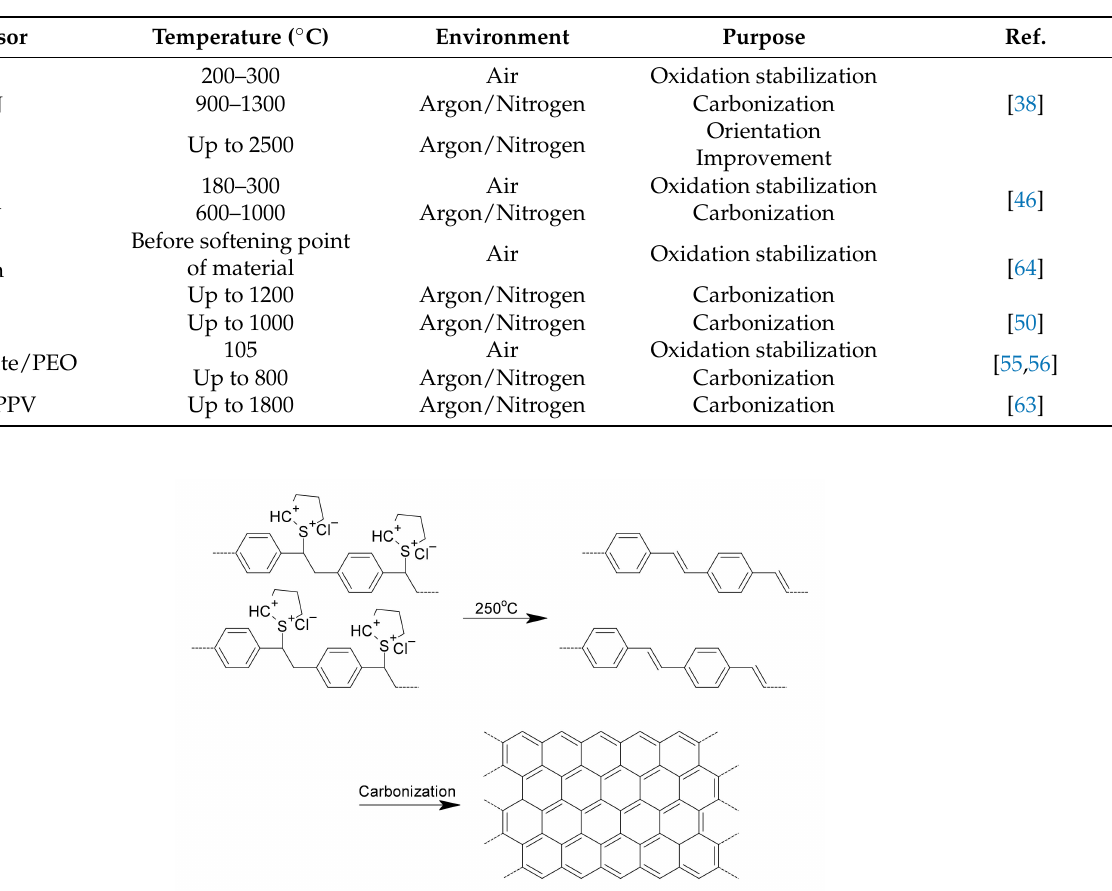
Table 1. Changes in carbonization temperature and gas-exposure conditions by polymer type.